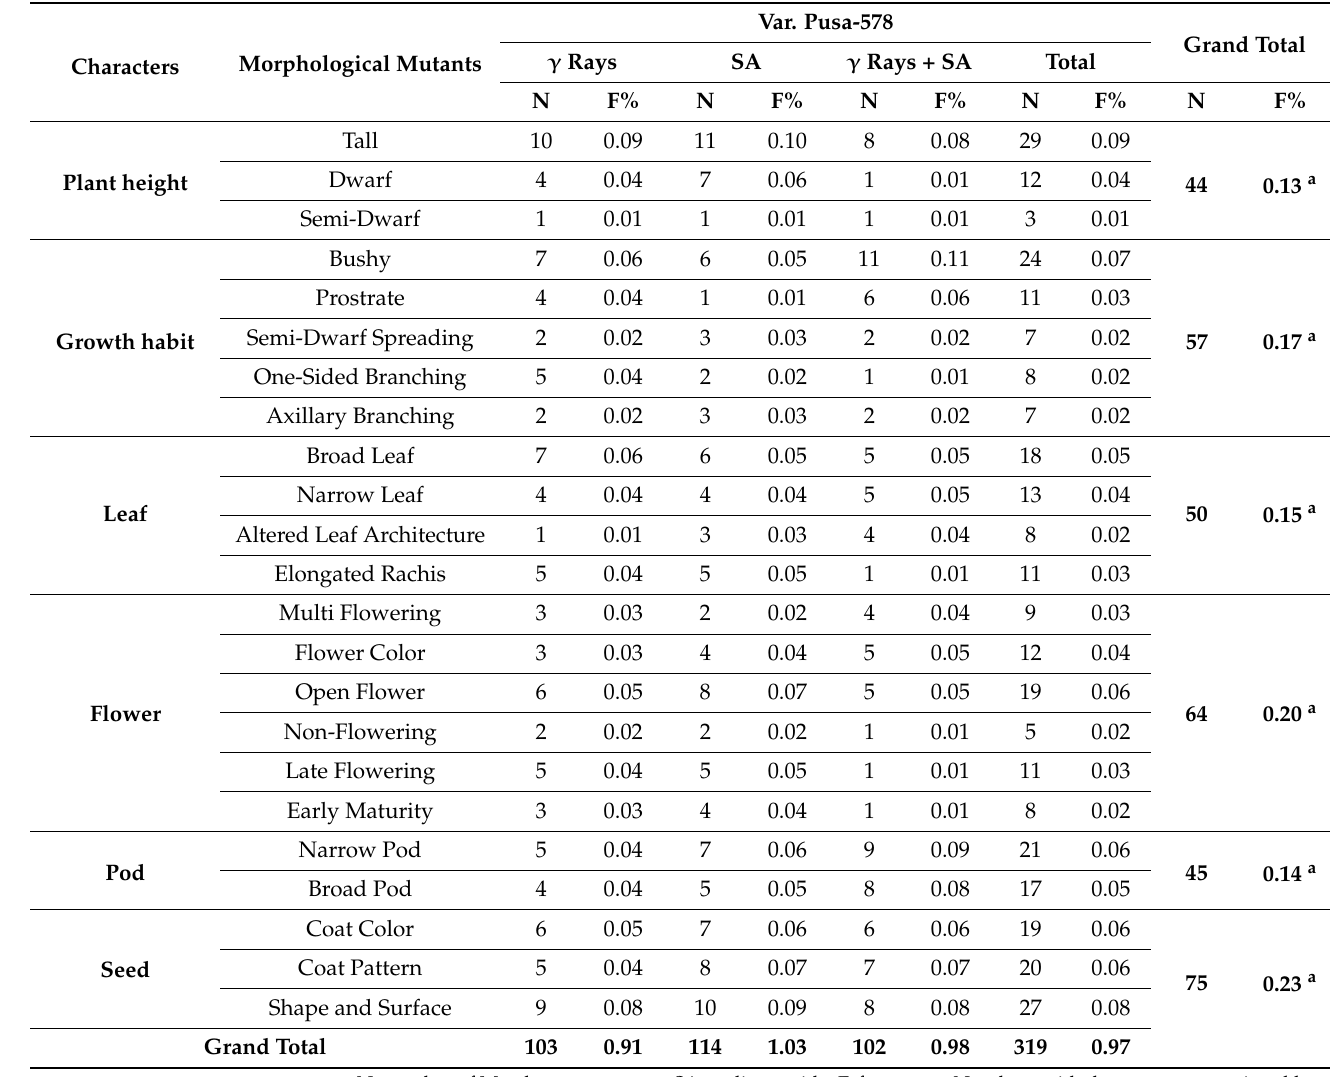
Table 7. Frequency and spectrum of morphological mutants in the M 2 generation of cowpea var.